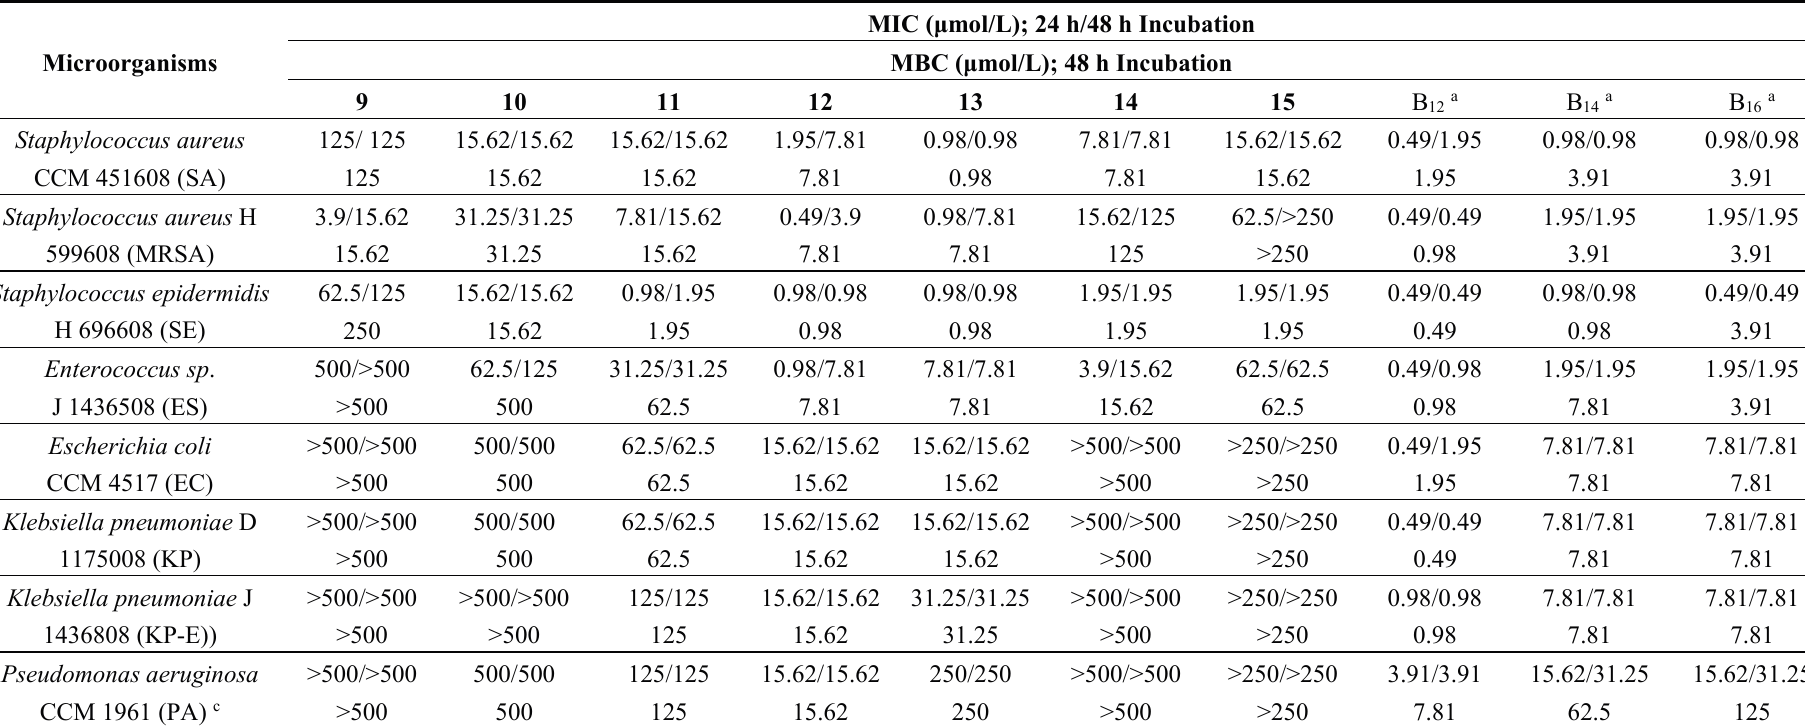
Table 3. Minimum inhibitory/bactericidal concentrations of the prepared compounds ( 9 – 15 ) and selected derivatives of N -benzalkonium (B 12 –B 16 ). The in vitro activities were determined on a panel of eight bacterial strains.